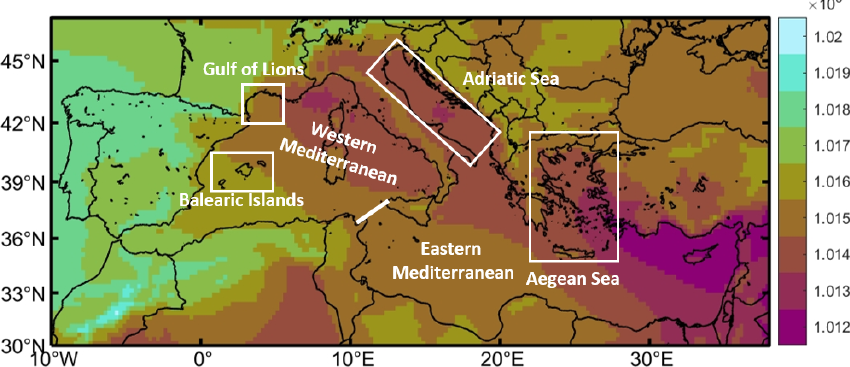
Figure 2. Average SLP (in Pa) for the year 2013 in the region, computed from the ERA5 dataset. The red line at the Strait of Sicily marks the boundary between the western and eastern basins. The red rectangles limit the sub-basins of the Balearic Islands, the Gulf of Lions and the Aegean Sea, where specific analyses were carried out.